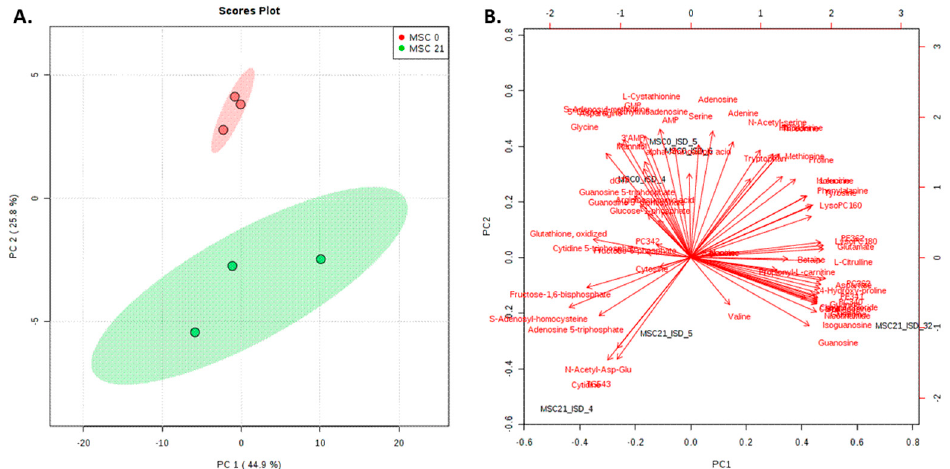
Figure 2. Principal component analysis (PCA) for the targeted lipid and metabolite analysis comparing MSCs and adipocytes. All compounds were quantified (54 metabolites, 12 lipids) using compound-specific quantification with 13 C-labeled yeast extract. ( A ) PCA score plots in MetaboAnalyst 4.0 [32] explaining 71% of the variance by PC 1 and PC 2 showing separation of the MSCs (MSC0) and adipocytes (MSC21) despite the higher variation in adipocytes. ( B ) Biplot (MetaboAnalyst) including the loading information of the individual metabolites/lipids.